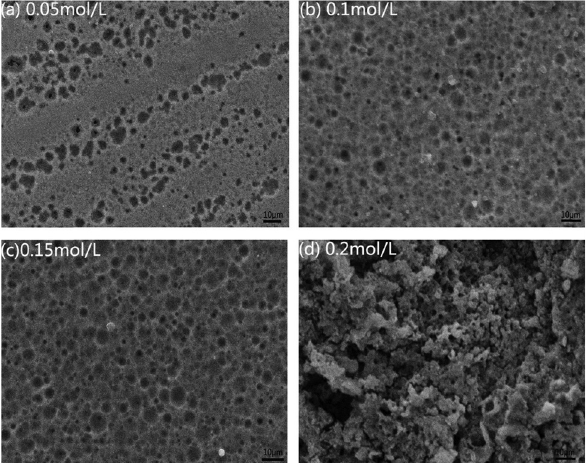
Figure 6: SEM image of the surface of anodized alloy with di ff erent concentrations of ammonium fl uoride at 20°C: ( a ) 0.05 mol/L, ( b ) 0.10 mol/L, ( c ) 0.15 mol/L, and ( d ) 0.20